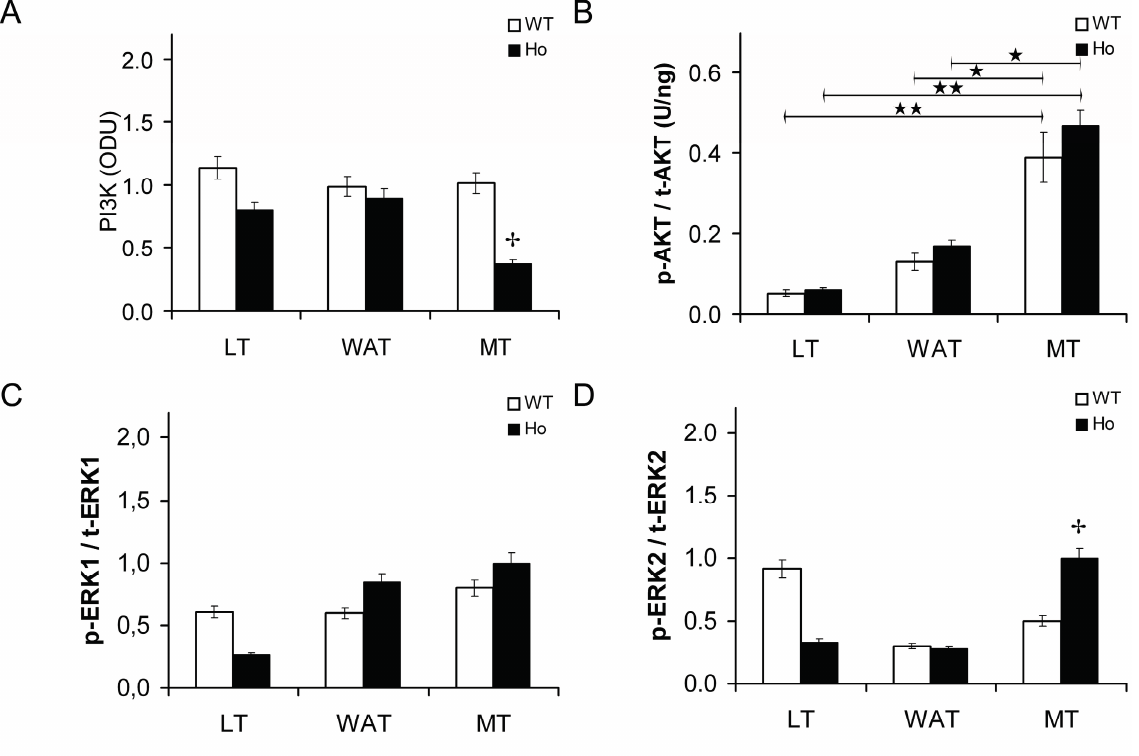
Figure 9. PI3K content, p-AKT/t-AKT, p-ERK1/t-ERK1 and p-ERK2/t-ERK2 ratios in mouse tissues. Phospho inositol kinase p85 subunit (p85 PI3K) content ( A ); activated [S473]/ total AKT ratio (p-AKT/t-AKT) ( B ); activated [T202/Y204]/total ERK1 (p-ERK1/t-ERK1) ratio ( C ); and activated [T185/Y187]/total ERK2 (p-ERK2/t-ERK2) ratio ( D ) in 129/FVB CF-affected mice (Ho) and in their wild-type littermates (WT) in baseline condition in liver (LT), white adipose (WAT) and skeletal muscle tissues (MT). ( A ) p85 PI3K content was expressed in optic densitometry units (ODU). p85 PI3K was lower in CF mice; ( B ) p-AKT/t-AKT ratio expressed in U/ng, was similar in both normal and CF mice, but higher in muscle tissue. The bars represent the mean ± SEM of all experiments in both groups.  p < 0.01 LT vs . MT;  p < 0.05 WAT vs .